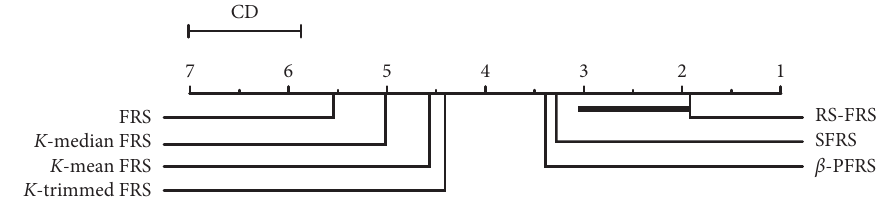
Figure 5: CD diagram of different FRS models on CART based on Bonferroni-Dunn statistical method.